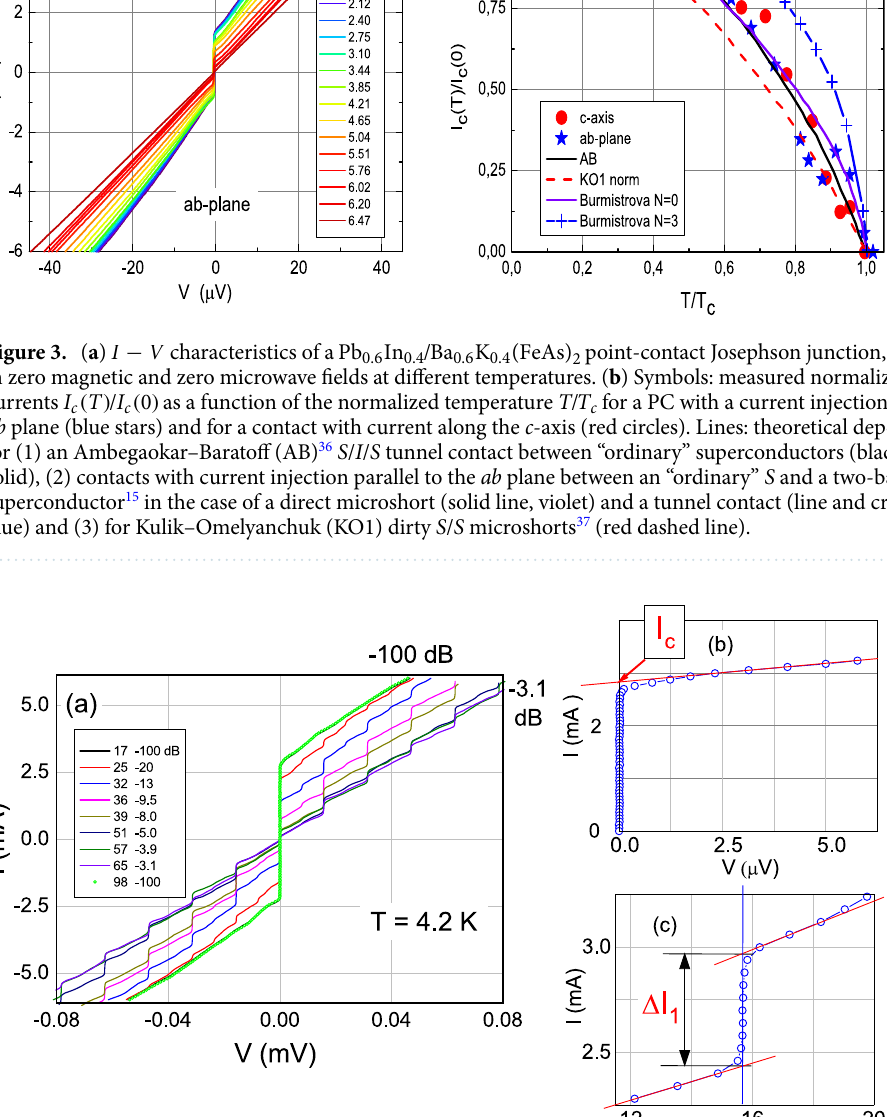
towards V = 0 , while in panel ( c ), the red lines indicate the extrapolation of the I − V curve measured closely to the current step in the region of this step. The critical current I c and the amplitude of the step were determined by the intersection of these lines with the current axis and with a vertical line drawn along the center of the step, respectively, which is a standard method for determining the amplitudes of the current steps I n ( n = 0, 1, 2, . . .) 34 . By analyzing in this way all the I − V curves recorded at different power levels, it is possible to extract the dependence of the amplitude of the current steps I n ( P ) normalized to the critical current at zero MW power,